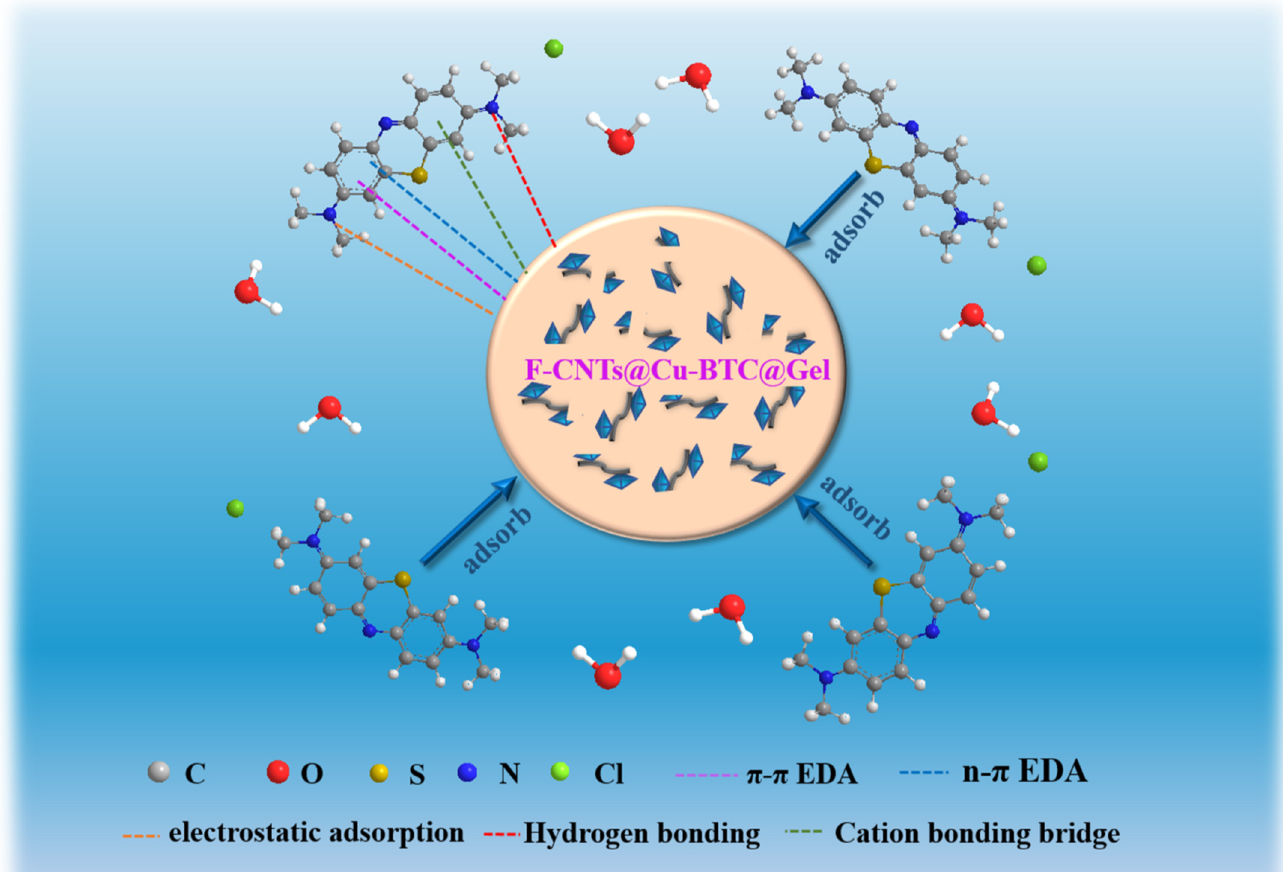
Figure 7. Adsorption mechanism of F-C-G for MB.